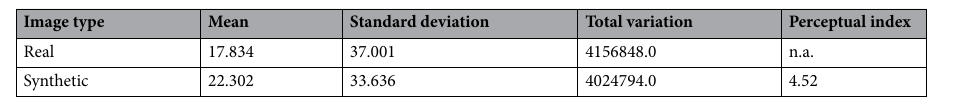
Table 1. Quantitative comparison between real THz images and CycleGAN synthetic